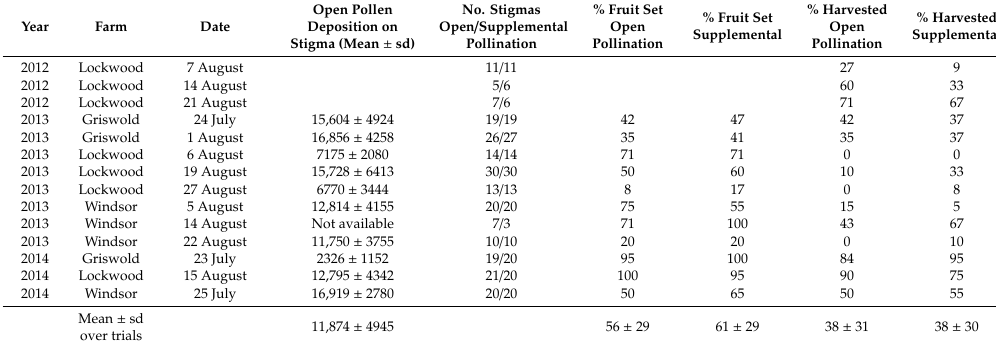
Table 1. Open pollen deposition on pumpkin stigmas and comparison of fruit set and survival to harvest from female pumpkin flowers pollinated naturally and with supplemental hand-pollination on three experimental farms.